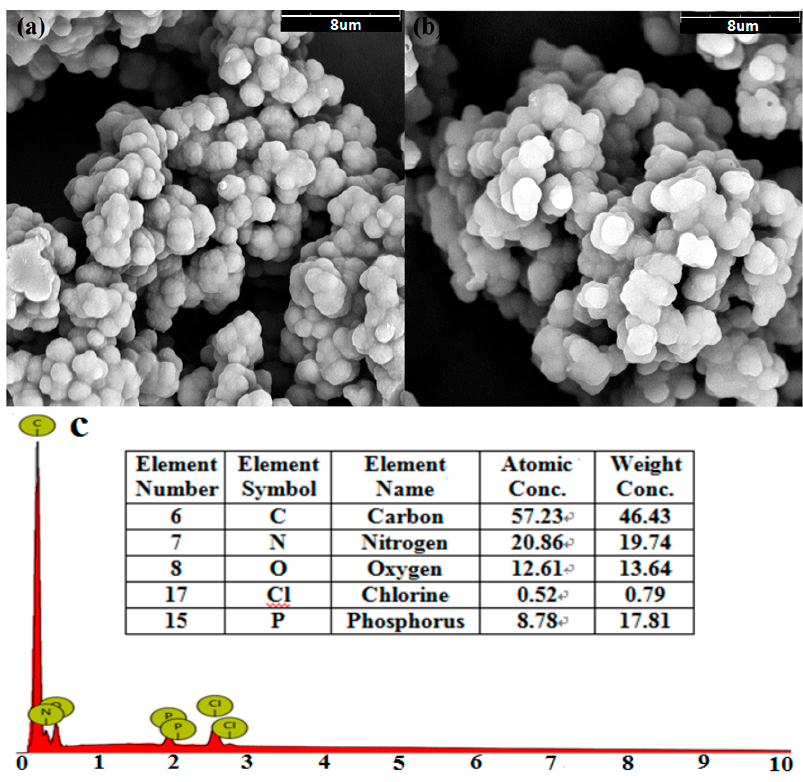
Figure 2. SEM images of polyaniline ( a ) and TP-AFC ( b ), EDS of TP-AFC ( c ).